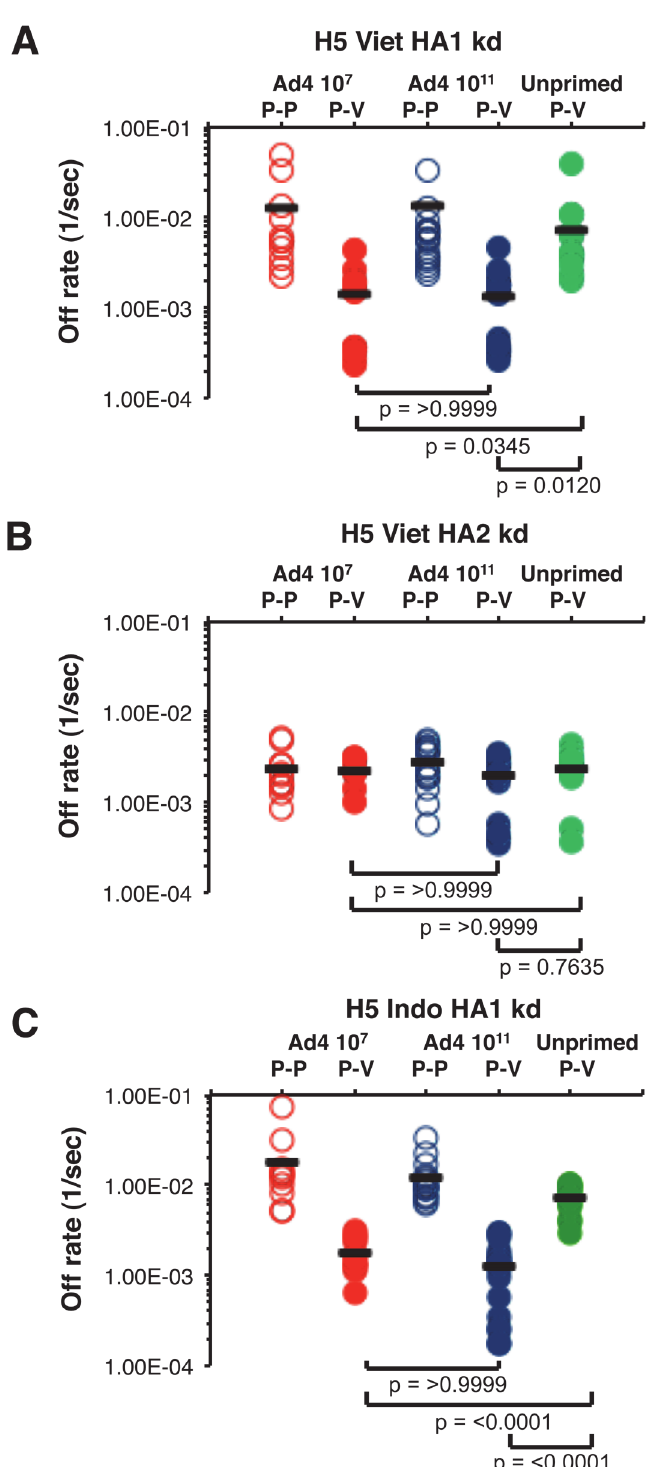
Fig 3. Ad4-H5-Vtn priming enhances antibody affinity (slower off-rates) to H5N1-HA1 (but not HA2) following a single H5N1 subunit vaccine boost. (A-C) SPR analysis of post-H5N1 vaccinated human sera after the H5N1-A/Vietnam/1203/2004 subunit vaccine boost in three vaccine groups was performed with properly folded HA1 (A) or HA2 (B) from H5N1 A/Vietnam/1203/2004 strain, or rHA1 of the heterologous H5N1-A/Indonesia/5/2005 (Clade 2.1) strain (C). Off-rates of polyclonal serum antibodies before